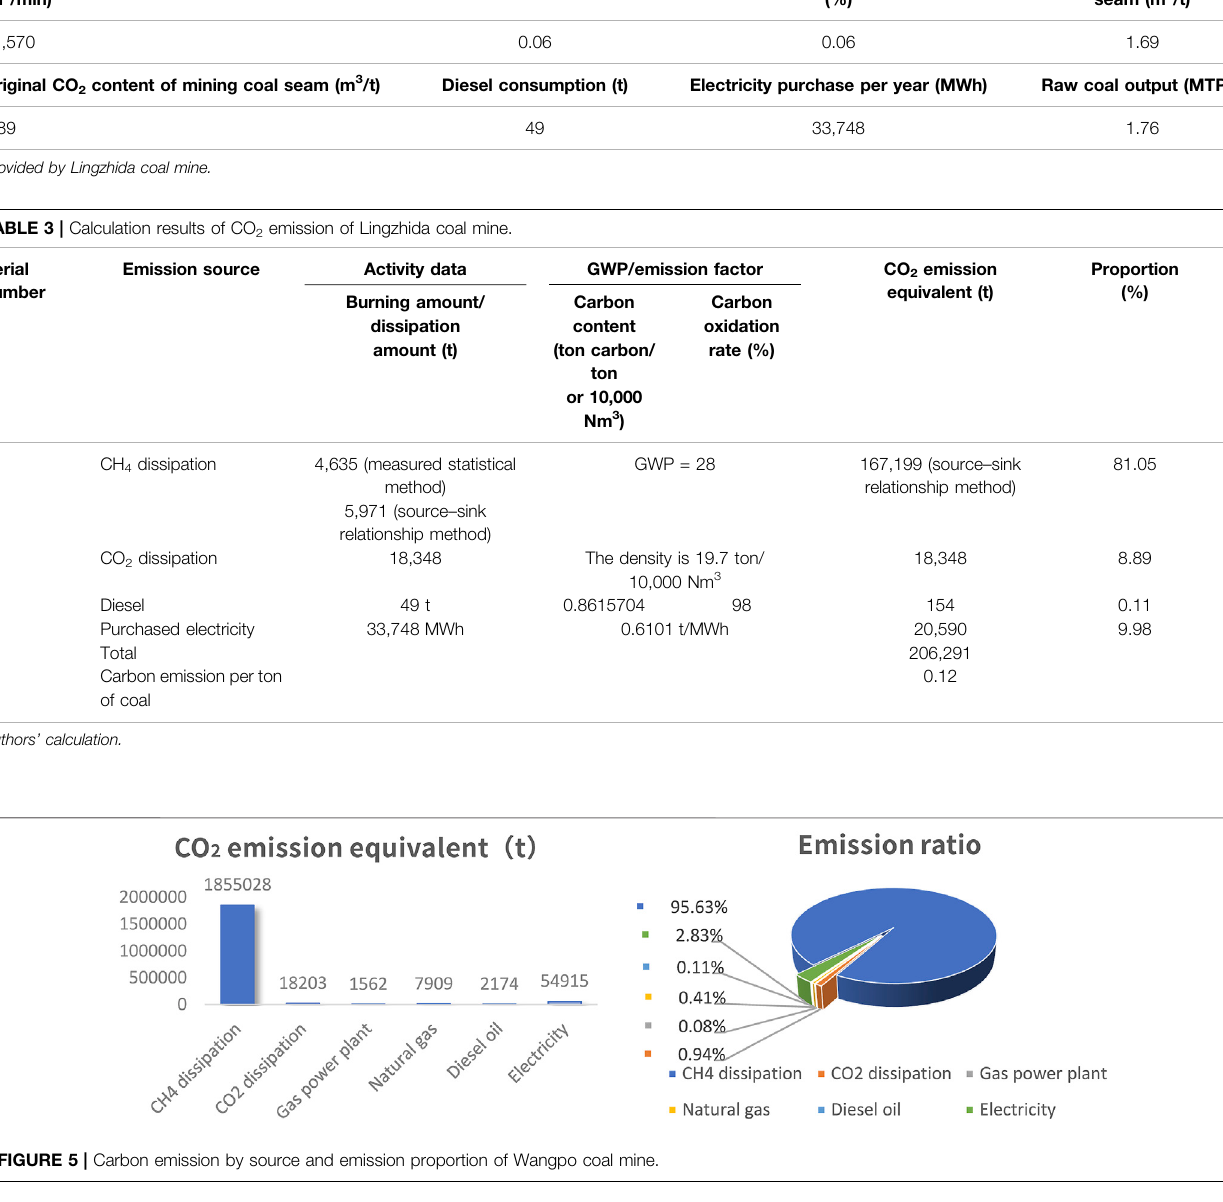
Frontiers in Energy Research |